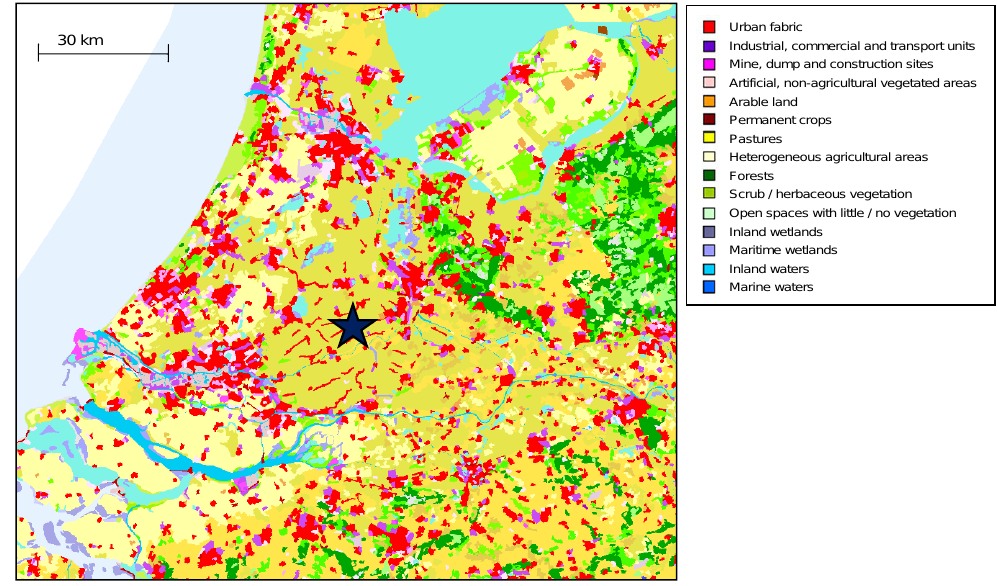
Fig. 1. Corine land cover 2000 (CLC2000) map around the Cabauw tall tower station. The star shows the location of the Cabauw tower.